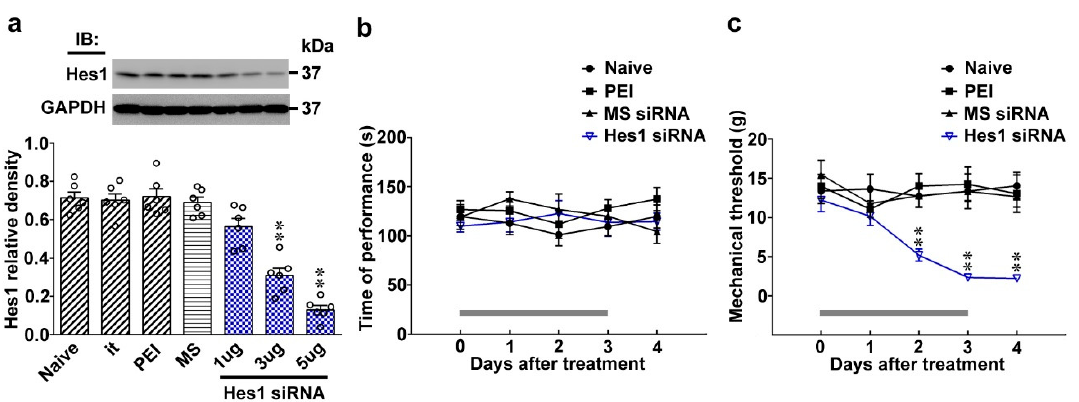
Figure 2. Focal knockdown of spinal Hes1 expression elicits no motor deficits but provokes behavioral allodynia. ( a ) Representative Western blot and statistical analyses (normalized to GAPDH) showing the Hes1 levels in the dorsal horn dissected from naïve animals (Naïve) were not affected by implantation of an intrathecal catheter alone (it) or spinal administration with polyethylenimine (PEI, 10 μ L; daily for 4 days) or missense siRNA (MS siRNA, 5 μ g, 10 μ L; daily for 4 days) but was dose ‐ dependently decreased by intrathecal administration with Hes1 siRNA (Hes1 siRNA; 1, 3, and 5 μ g; 10 μ L; daily for 4 days) at day 4 after the start of treatments. IB, Immunoblotting. One ‐ way ANOVA, post ‐ hoc Tukey test, F (6,35) = 47.9, p < 0.0001. ** p < 0.01 vs. Naïve. n = 6. ( b ) Rota ‐ rod test demonstrating no statistical difference in the motor performance among naïve animals as well as naïve animals administered with polyethylenimine, missense siRNA, or Hes1 siRNA (5 μ g, 10 μ L). The gray bar at the bottom indicates the duration of the reagents’ administration. Two ‐ way ANOVA with repeated measures over time, treatment, F (3,24) = 1.170, p = 0.3419; time, F (4,96) = 0.2094, p = 0.9327; treatment × time, F(12,96) = 0.8289, p = 0.6205. n = 7. ( c ) Results of the von Frey test demonstrating that administration to naïve rats with Hes1 siRNA (5 μ g, 10 μ L), but not polyethylenimine, or missense siRNA decreased the withdrawal threshold of the hind paw at days 2, 3, and 4 after the injection. The gray bar at the bottom indicates the duration of the reagents’ administration. Two ‐ way ANOVA with repeated measures over time, treatment, F (3,24) = 40.16, p <